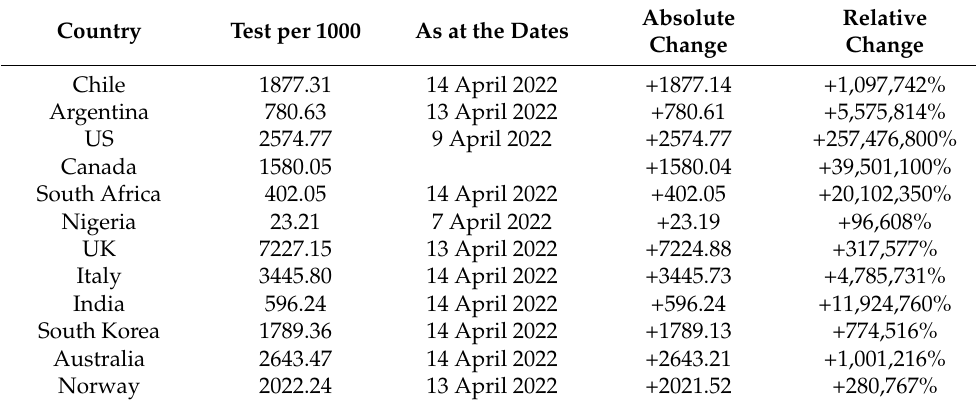
Table 4. Total COVID-19 tests relative to country population (per thousand)—test per 1000. Country Test per 1000 As at the Dates